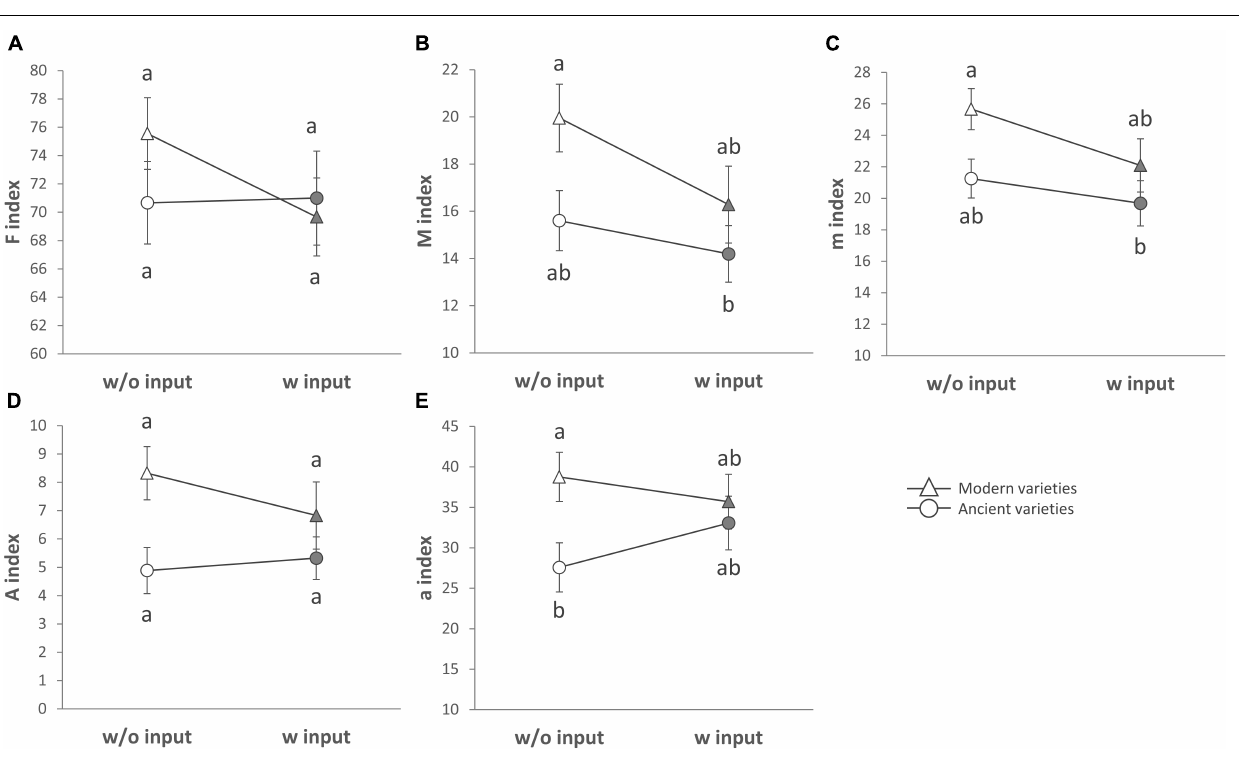
FIGURE 4 | Mycorrhizal colonization for breeding types and inputs that are presented as reaction norms. Panels are respectively showing (A) the frequency of root fragments with mycorrhizal structures on the root system scale, intensity of mycorrhizal colonization on the root (B) system scale, or (C) restricted to mycorrhizal root fragments (D) arbuscule abundance on the root system scale or (E) restricted to mycorrhizal root fragments for each type of breeding (modern varieties with triangles, ancient varieties with circles) in response to the presence of inputs. Significance was inferred by ANOVA under Tukey’s HSD post hoc test for normally distributed data (honest significant differences, p < 0.05). Data that were not normally distributed were analyzed by Scheirer-Ray-Hare test followed by post hoc FDR test correction to account for multiple testing (FDR, p < 0.05).